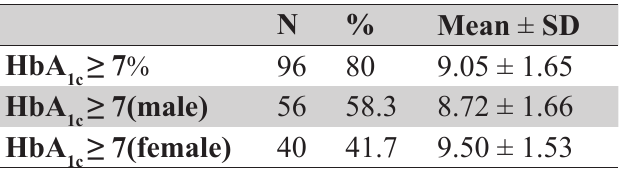
Table 2. Frequency and mean of poor glycemic